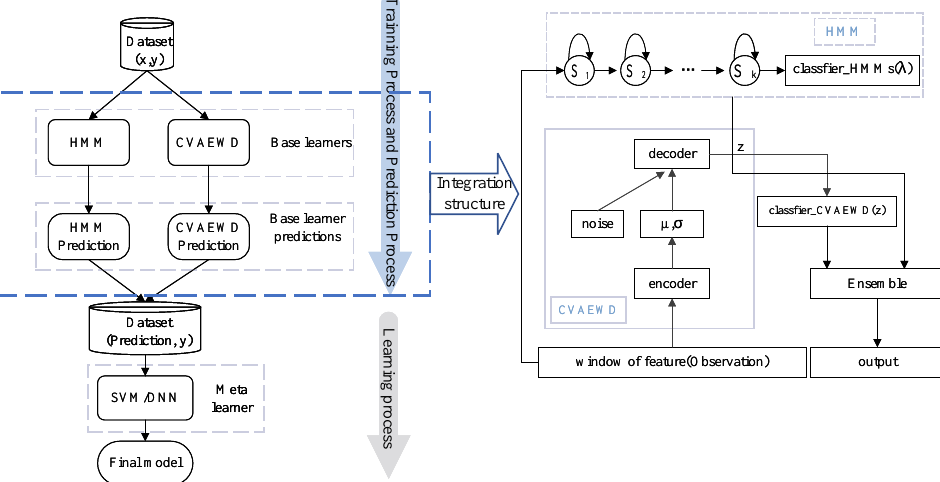
Figure 1. Schematic diagram of HCW overall structure and stacking